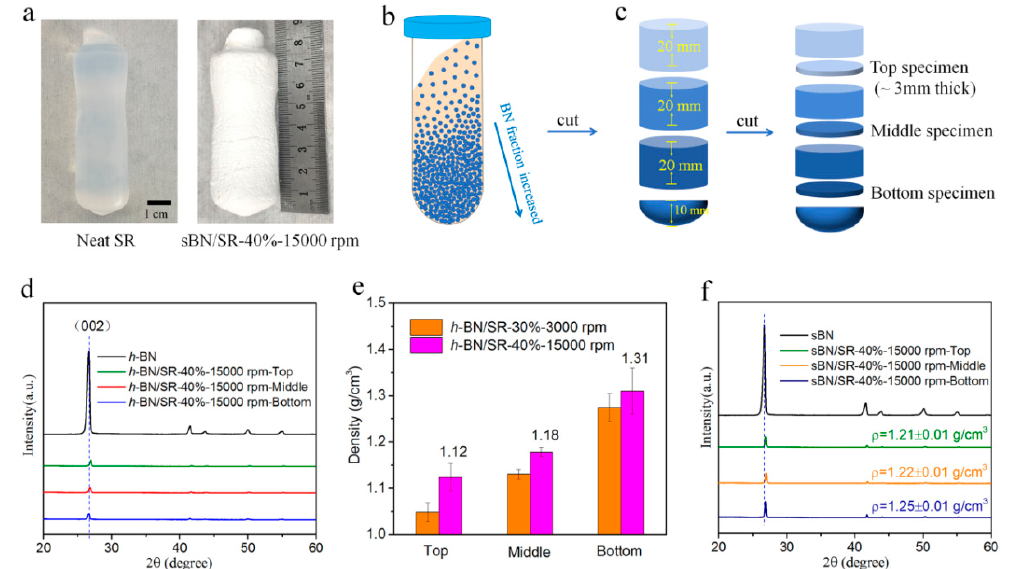
Figure 3. Hypergravity-induced accumulation of BN. ( a ) Photograph of neat silicone rubber and sBN/silicone rubber (SR) composite prepared with hypergravity treatments. ( b ) Scheme diagram of the accumulation of BN. ( c ) Scheme diagram of cutting specimens from different parts of the composites. ( d ) XRD patterns of h ‐ BN and h ‐ BN/SR composites. ( e ) The density of h ‐ BN/SR composites in different parts. ( f ) XRD patterns of sBN and sBN/SR composites. The bottom specimens have stronger h ‐ BN’s (002) diffraction peaks and higher density than others, suggesting that hypergravity treatments lead to accumulation of BN in the bottom position of the composites. Table 1. Centrifugation speed and the corresponding relative gravity acceleration.